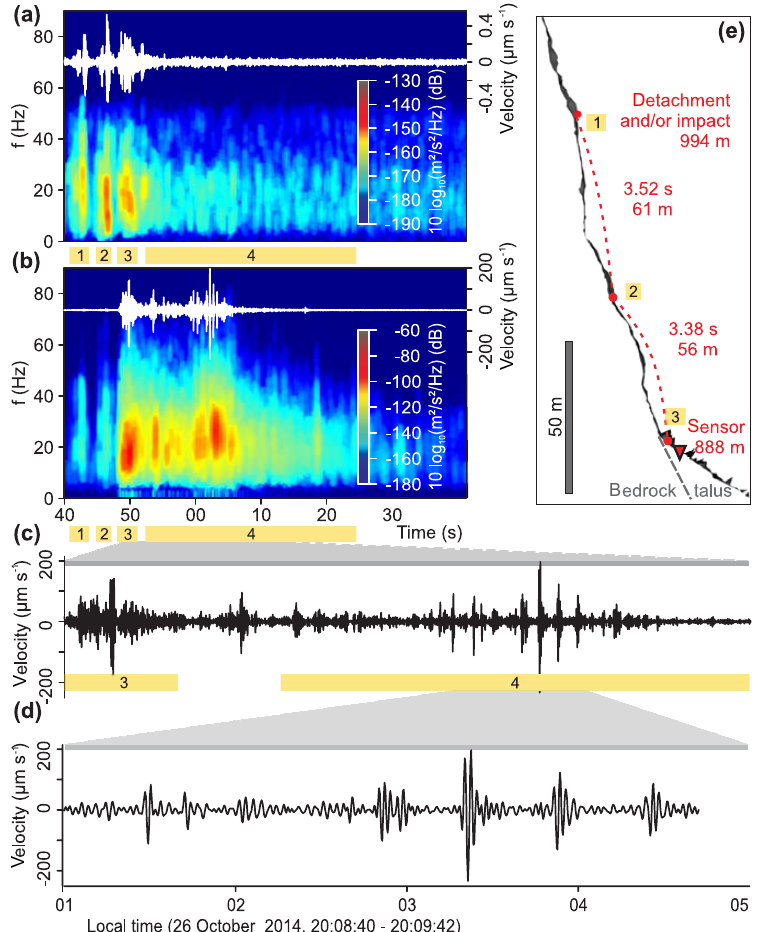
Figure 3. Seismic view of a rockfall (i.e., event 17) with multiple impacts and subsequent talus slope activity. The power spectral density estimate and waveform of stations “Basejumper’s Mess” (a) and “Funny Rain” (b) . The station on top of the cliff (a) mainly records the successive impacts along the cliff face, while the basal station (b) reflects the impact on the talus slope and subsequent slope activity. Note the different range of the colour schemes and waveform ranges in panels (a) and (b) . Panels (c) and (d) show zoomed-in records of station Funny Rain. Panel (c) shows the rock mass impact on the talus slope (phase 2) and subsequent activation of a single rock, first rolling and then jumping down the slope (phase 3). Panel (d) shows the individual hops of the rock as it approaches and passes the seismic station. Panel (e) shows a profile of the TLS data with detachment area (Dietze et al., 2017), sensor deployment position and free fall times as well as possible trajectories